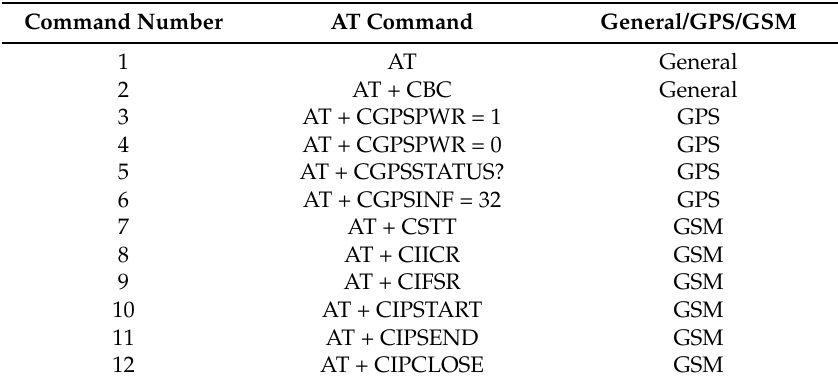
Table 2. The AT commands used for data transmission and